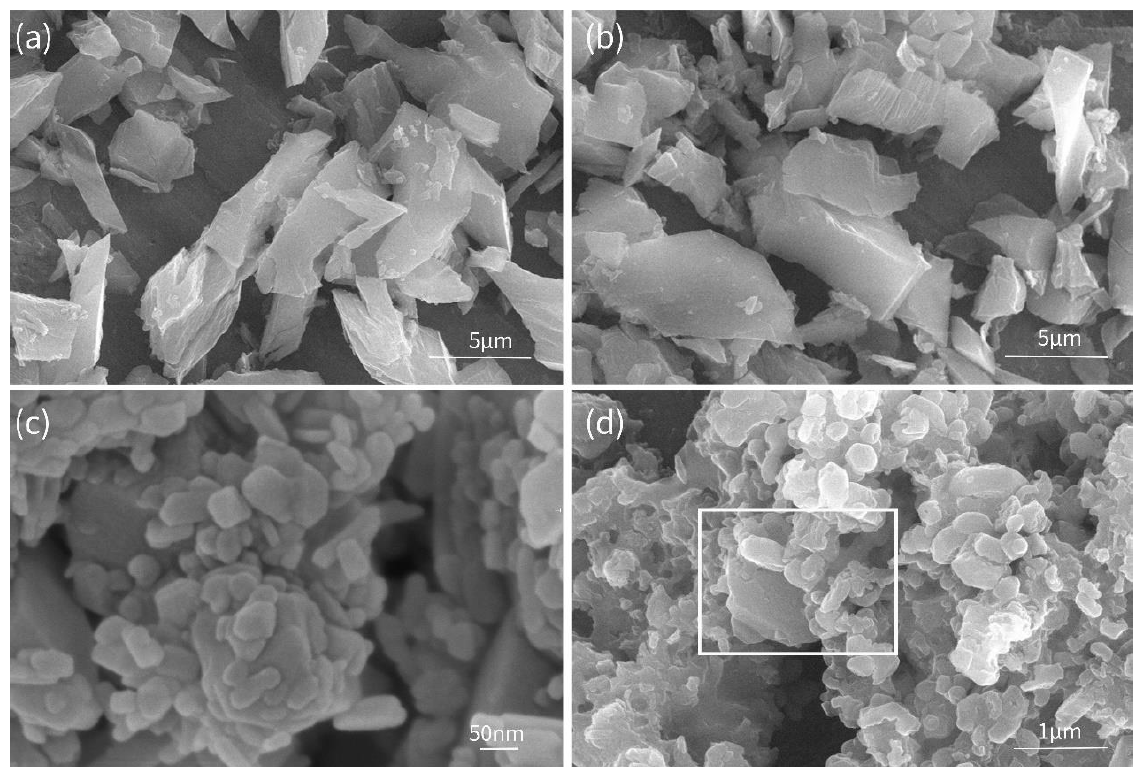
Figure 4. SEM images of modified MIL-53- and new Ca (OH) 2 -based desulfurizers. ( a ) MIL-53(Fe), ( b ) MIL-53(Fe)-BA, ( c ) Ca(OH) 2 , and ( d ) MIL-53(Fe)-BA/Ca (OH) 2 .